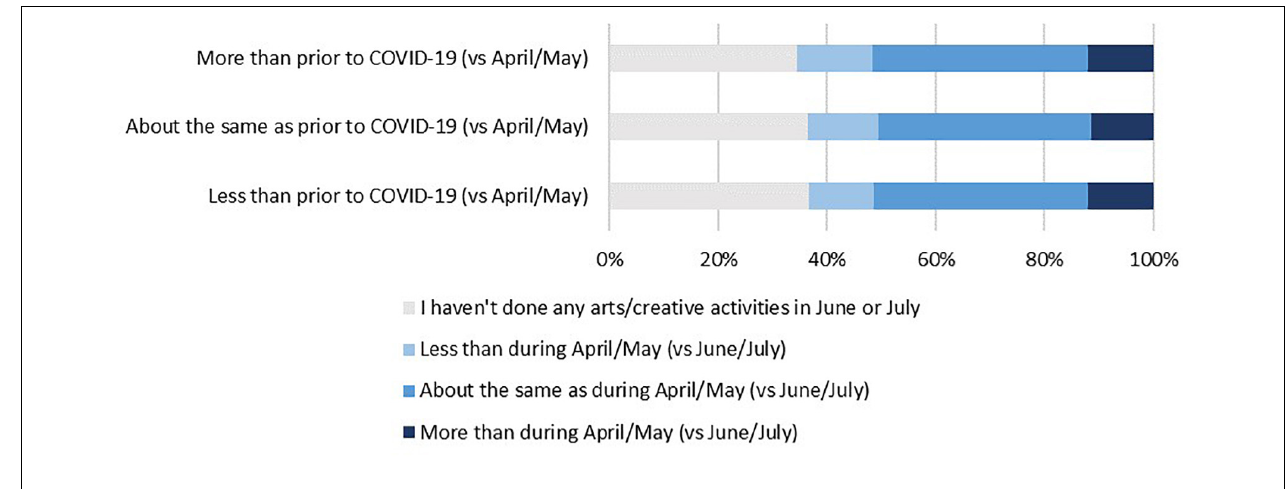
FIGURE 2 | Frequency of arts engagement in April/May during lockdown vs. engagement across